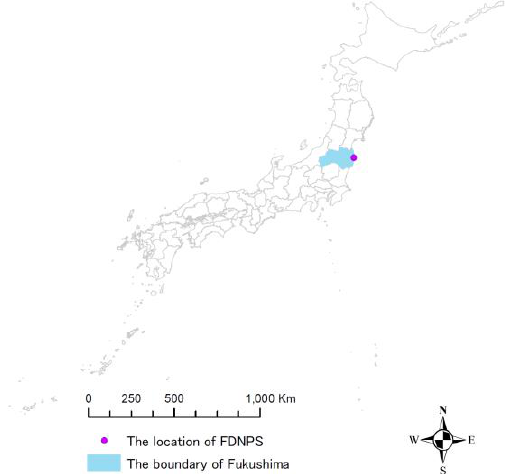
Figure 1. The location of the FDNPS (purple dot) and Fukushima Prefecture in Japan